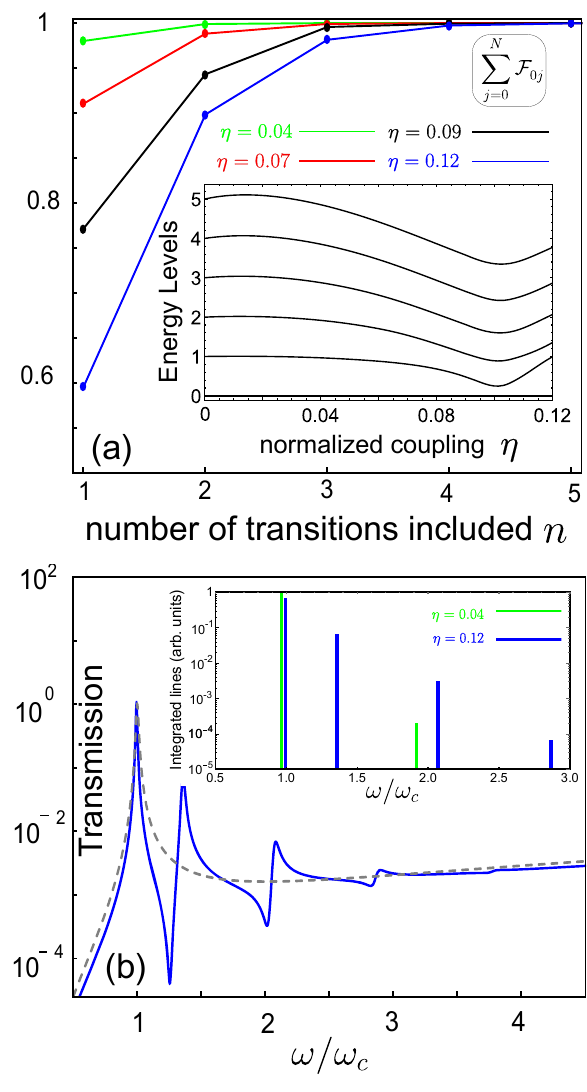
Figure 2: (a) Thomas – Reiche – Kuhn (TRK) sum rule for a single- F modenonlinearsystem:partialsums ∑ N 0 j versusthenumber( N ) j (cid:1) 0 of levels included for different normalized coupling strengths η . Inset: anharmonic energy spectrum ω k ,0 versus η . (b) Transmission spectrum T ( ω ) for a two-port nonlinear resonator for η (cid:1) 0 . 12. The inset shows the integrated lines for two values of η